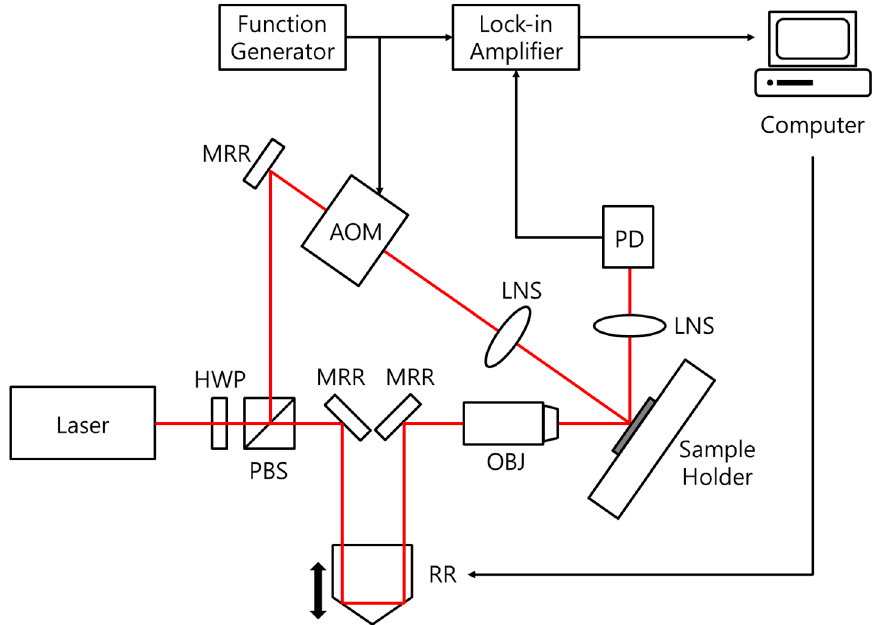
Figure 1. A schematic of the ultrafast pump-probe setup. AOM: acousto-optic modulator; HWP: half-wave plate; LNS: focusing lens; MRR: mirror; OBJ: objective lens; PBS: polarizing beam-splitter; PD: photodetector; RR: retroreflective mirror on a motorized translation stage.